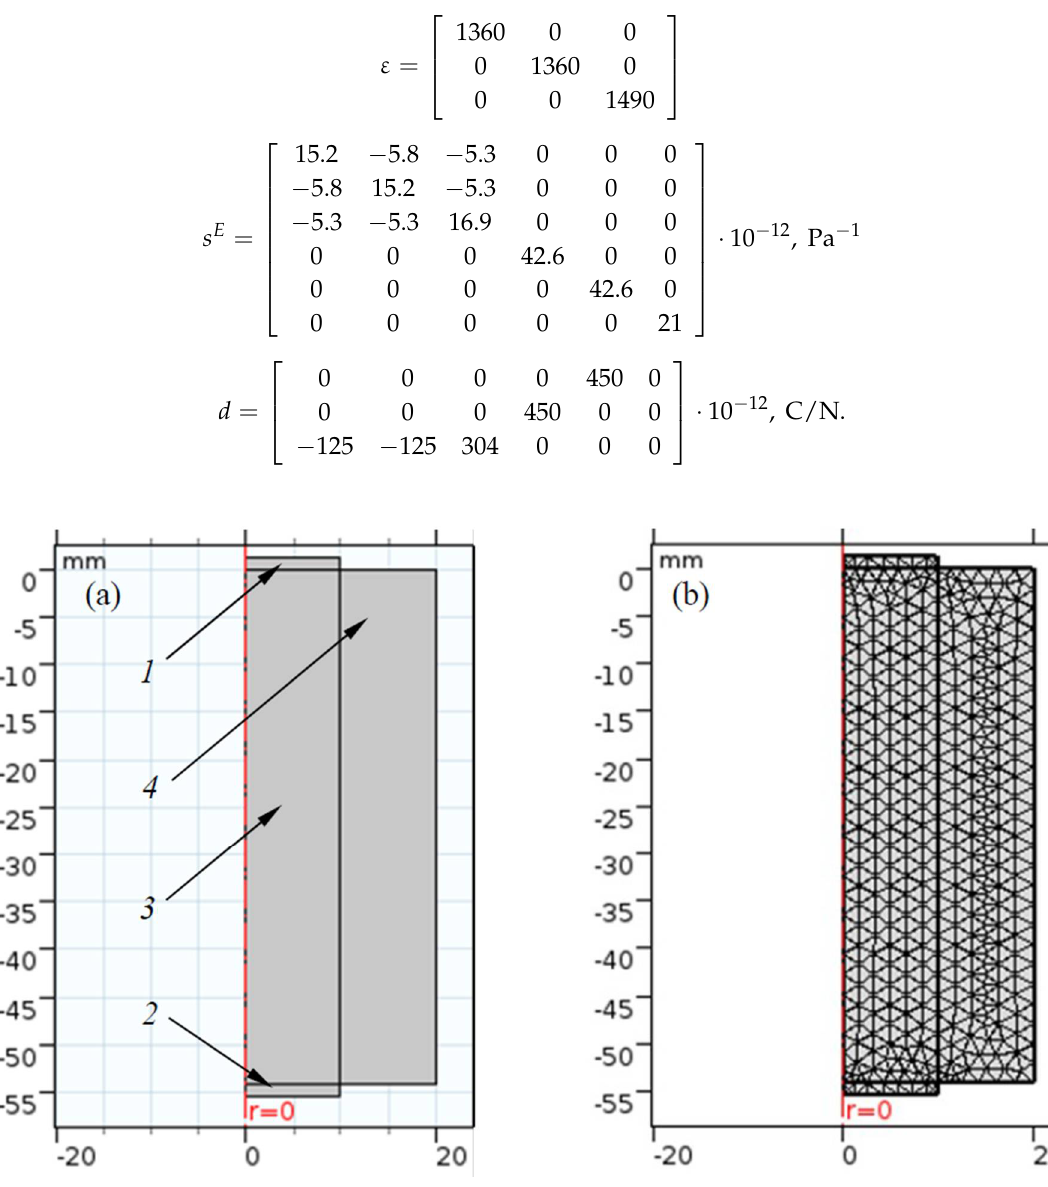
Figure 3. The studied geometrical area in the COMSOL Multiphysics environment: ( a ) two-dimensional (2D); ( b ) meshed simulation zone. The finite element method is only applicable for finite geometric size models. A divergence of the ultrasonic beam causes possible reflections from the boundaries of the glycerin layer 3 . The calculation model uses a perfectly matched layer 4 to avoid re-reflections. This layer omits without reflection waves falling into it from other zones, and does not reflect them back